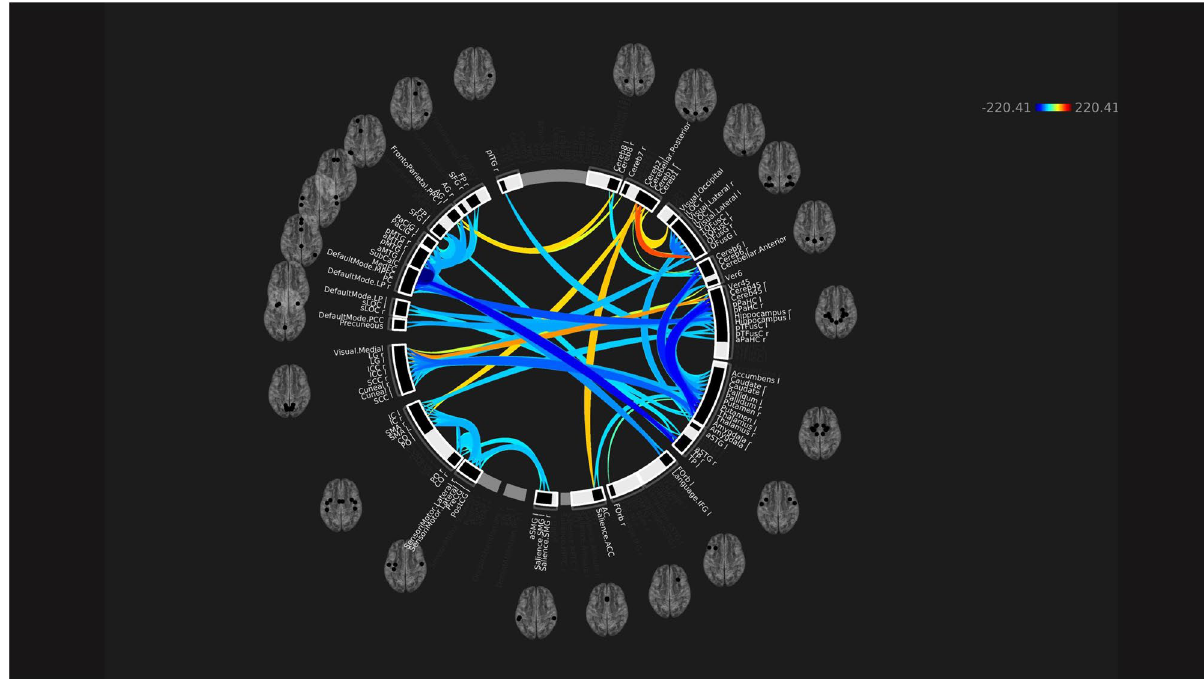
Figure 2. Significantly increased (warm colours) and decreased (cool colours) ROI-to-ROI connectivity in children with concussion in comparison to controls (mixed-sex